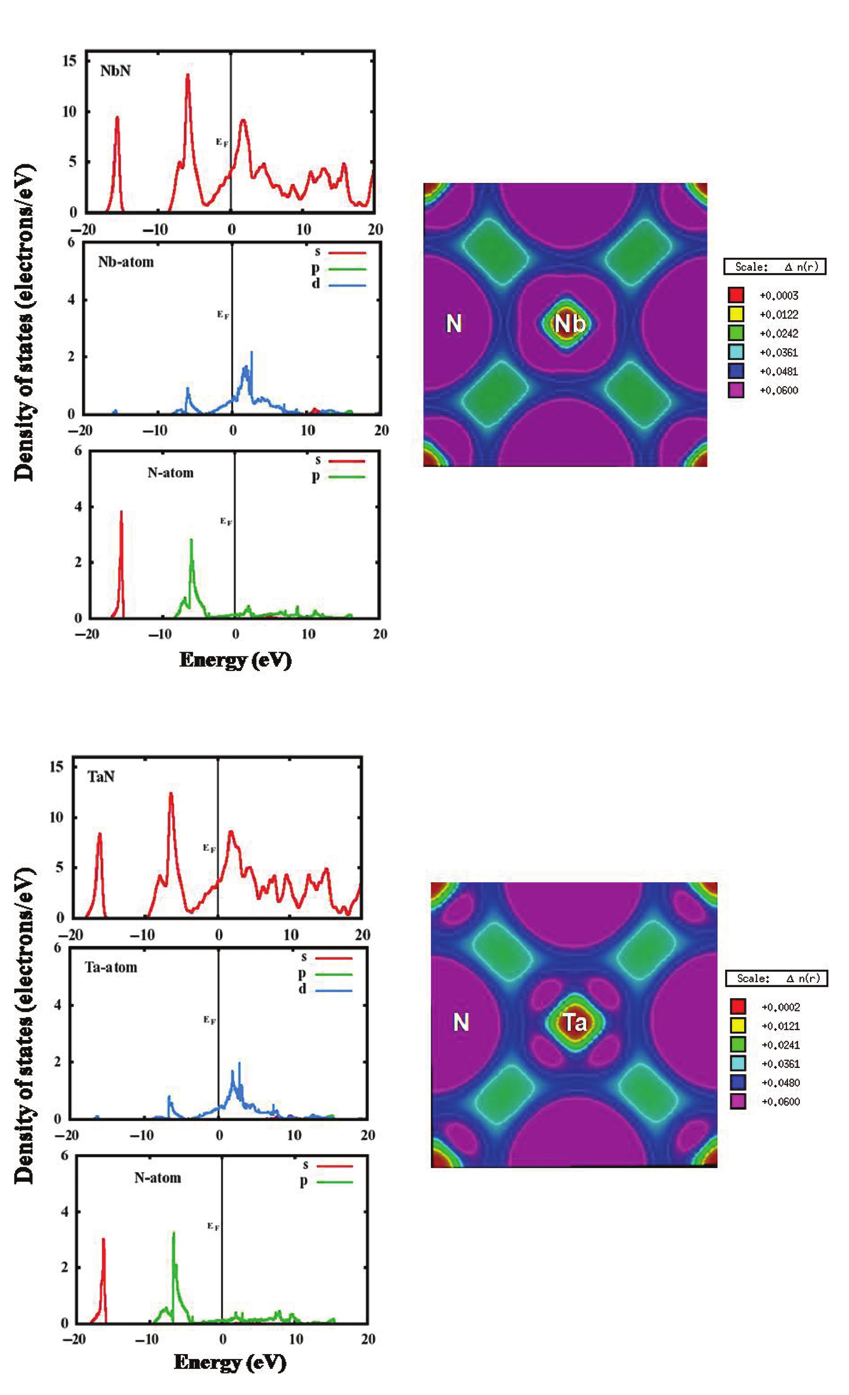
Figure 8: Electronic DOS and 2D charge density of